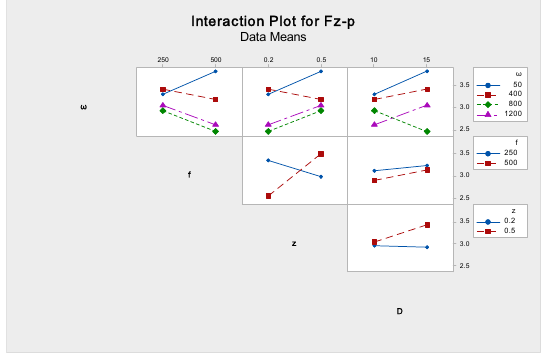
Figure 19. The interactions plot for the F z-p .